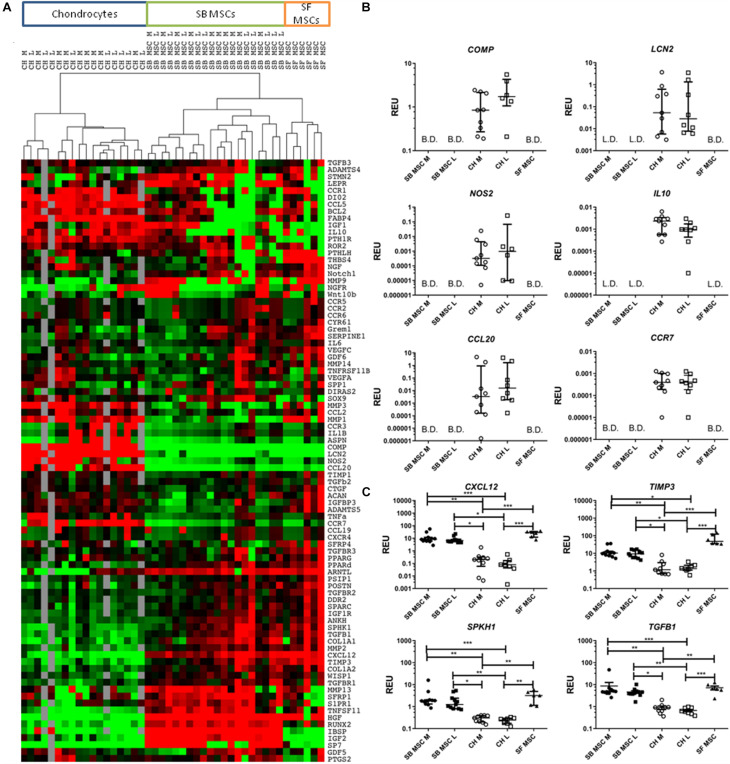
Gene expression analysis of culture-expanded medial and lateral subchondral bone (SB) multipotent stromal cells (MSCs) (SB MSC M and SB MSC L, respectively), synovial fluid (SF) MSCs, and medial and lateral chondrocytes (CH M and CH L, respectively). (A) Cluster analysis between CH, SB MSCs, and SF MSCs illustrating clear clustering of MSCs away from chondrocytes. Data were normalized to the housekeeping gene HPRT and log2 transformed. Data filtering was performed according to standard methods previously described (Churchman et al., 2012). Scores were assigned as: black = 1, red > 1, green < 1; gray = missing data (below detection). (B) Differentially expressed genes with a significant higher expression in chondrocytes than in MSCs. L.D. indicates transcripts which were rarely expressed (in < 50% samples), and B.D. indicates transcripts below detection. (C) Differentially expressed genes between chondrocytes and MSCs, which were statistically significantly higher expressed in MSCs than in chondrocytes. *p < 0.05; **p < 0.01; ***p < 0.0001. Horizontal bars show medians and error bars represent interquartile range (IQR). REU, relative expression units [relative to housekeeping hypoxanthine phosphoribosyltransferase (HPRT)].